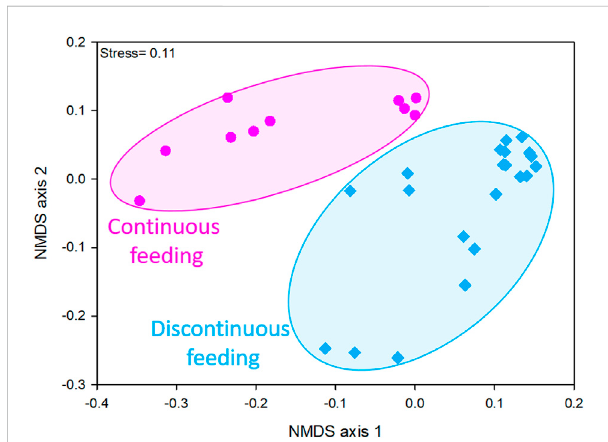
FIGURE 1 NMDS ordination plots, based on Bray-Curtis distance matrixes of log (X+1)-transformed sequencing data (community at genus level ≥ 1% in at least one sample). The stress value (i.e., < 0.2) suggests for an accurate representation of the dissimilarity among